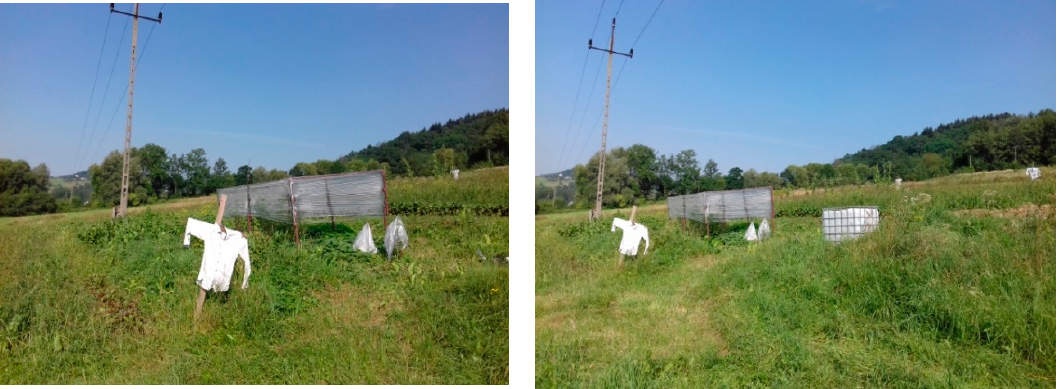
Figure 2. Scarecrows in a potato field, next to vegetables. Near Grybów (Małopolskie Voivodeship). Source: author.